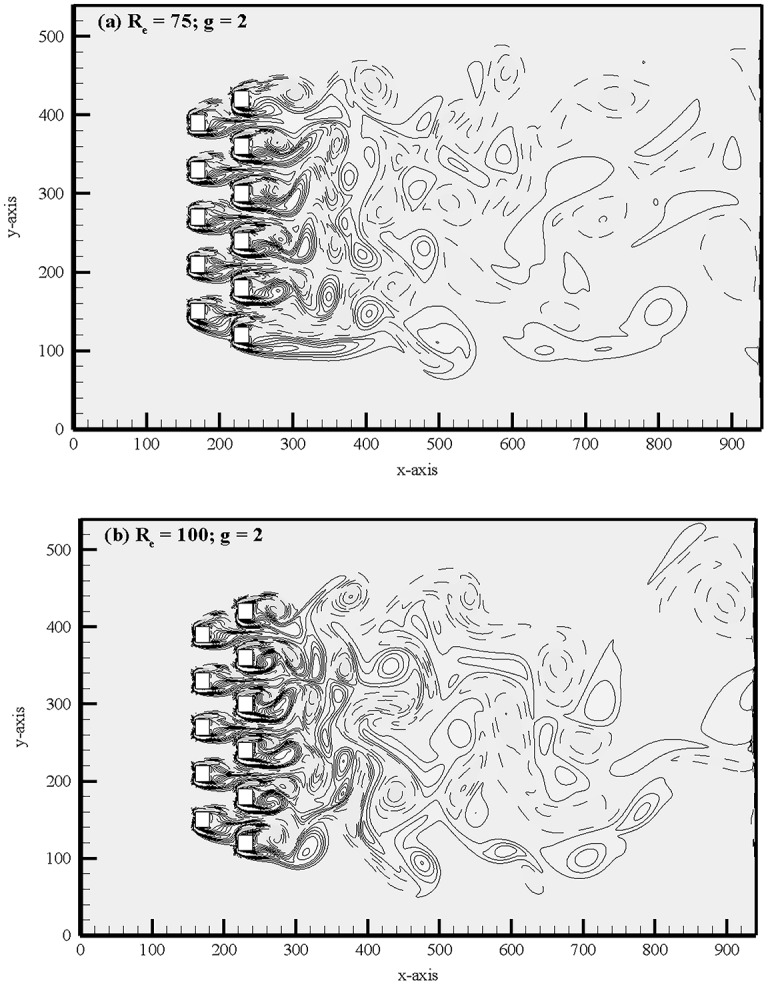
Instantaneous vorticity contours visualization at (a) (Re, g) = (75, 2) and (b) (Re, g) = (100, 2).